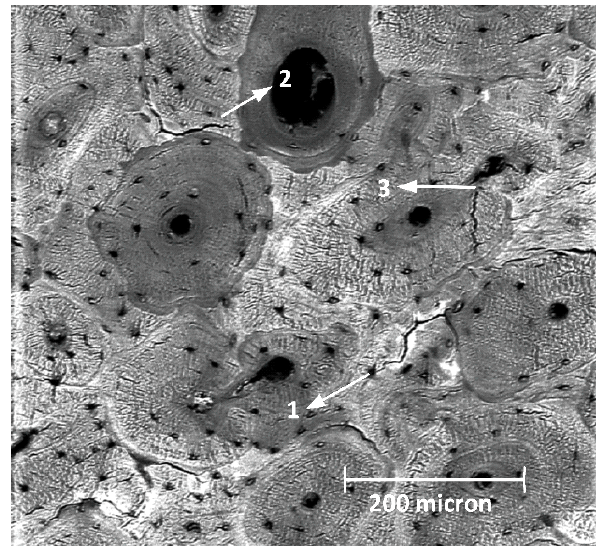
Figure 3: The SEM image of the middle region of cortical bone af- ter loading. The white arrow 1 indicates the phenomenon “cracks captured by the cement line”, the white arrow 2 indicates the phe- nomenon “cracks deflected by the osteon”, and the white arrow 3 indicates the phenomenon “cracks absorbed by the osteon”.